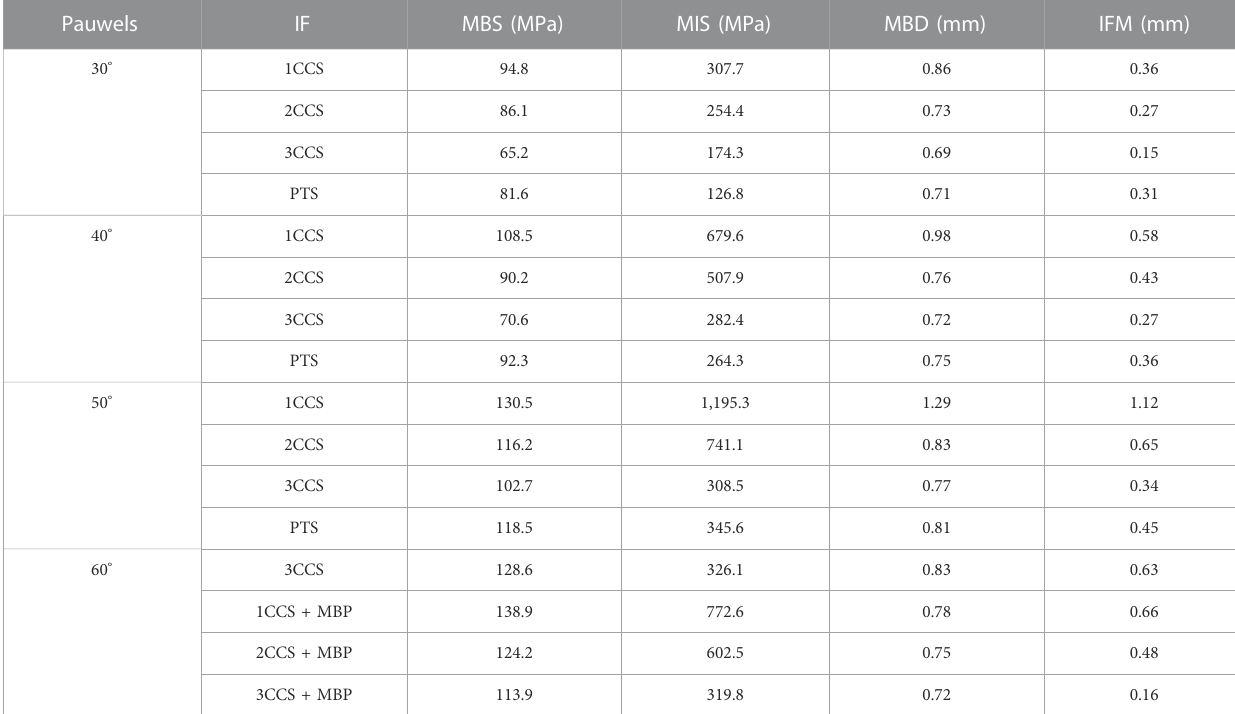
TABLE 2 Parameters results of FE models.